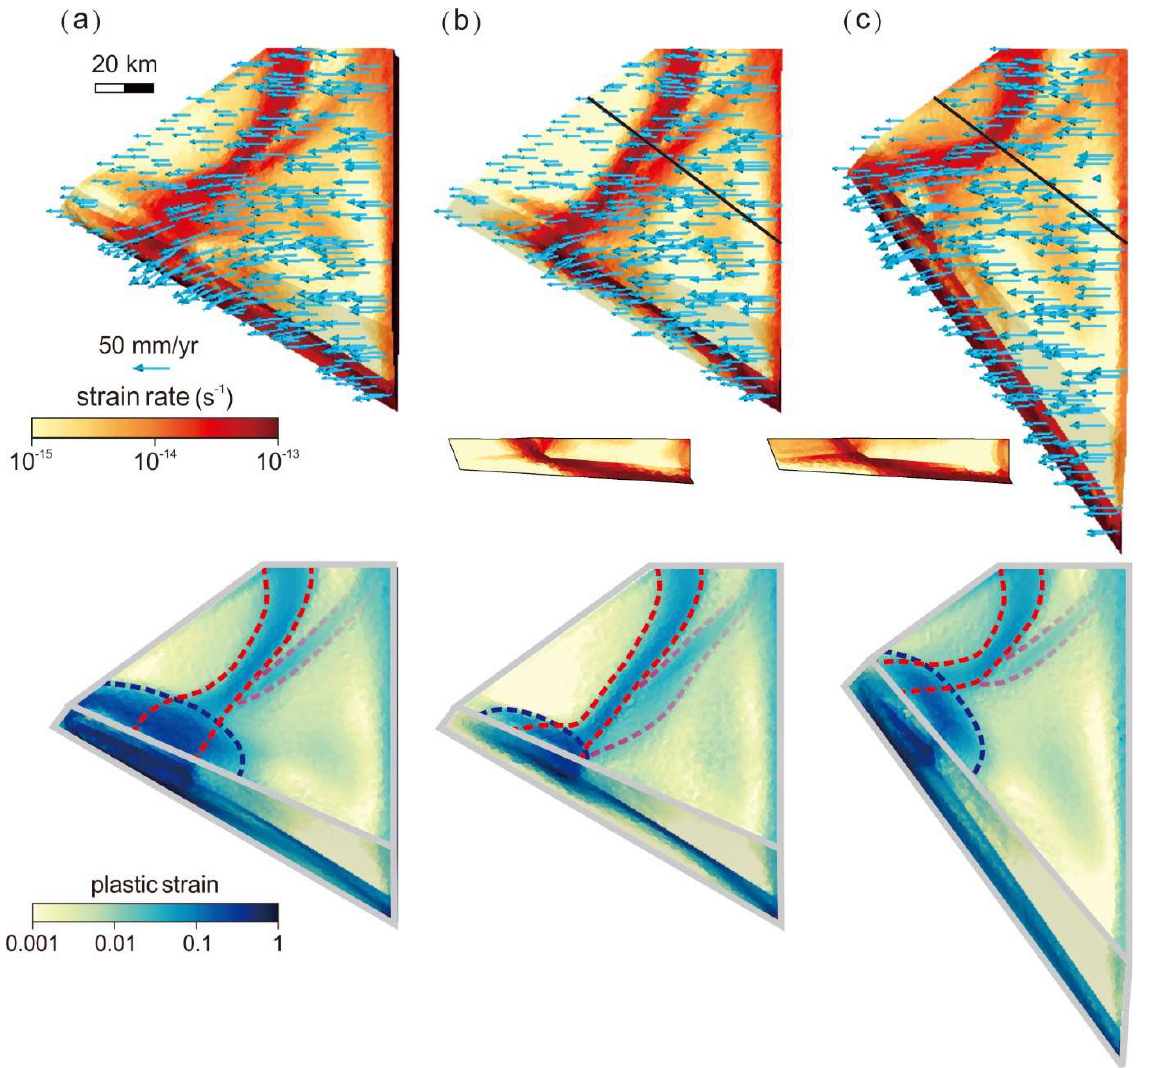
Figure 9. Comparison of strain rate fields and plastic strain fields between models. Dashed lines indicate structures. The red dashed lines mark the forethrusts; the purple dashed lines mark the backthrusts; the blue dashed lines mark the slumping areas in the early stage. ( a ) Model in which Φ b = 2.5° and α = 113.73°. ( b ) Model in which Φ b = 5° and α = 113.73°. ( c ) Model in which Φ b = 2.5° and α = 140.09°.